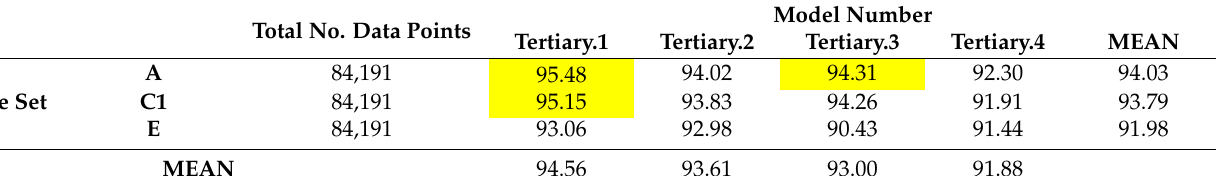
The confusion matrices for the top 3 performing models, highlighted in yellow in Table 9, are shown in Figure 2a–c, respectively.